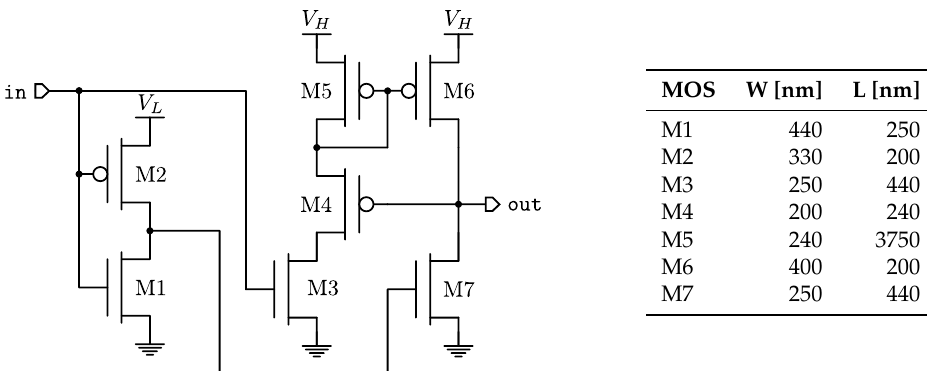
Figure 7. Wilson current-mirror based level shifter and transistor optimized geometrical parameters values for the design case in Section